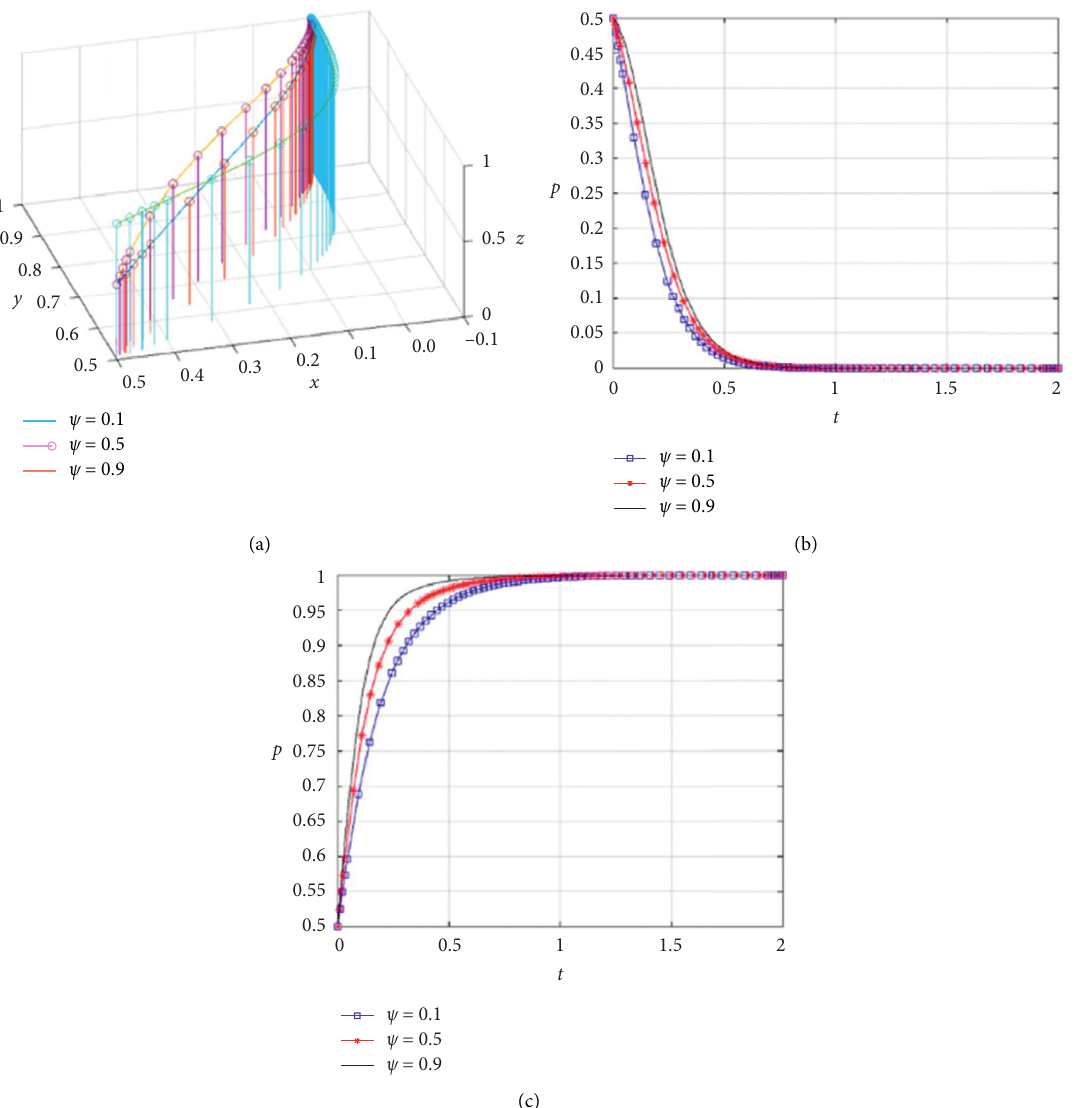
Figure 5: Simulation diagram of evolution path of each subject’s behavior under different government punishment coefficients. (a) The evolution of system under different government punishment coefficients. (b) Simulation of evolution path of government behavior under different government punishment coefficients. (c) Simulation of evolution path of enterprise behavior under different government punishment